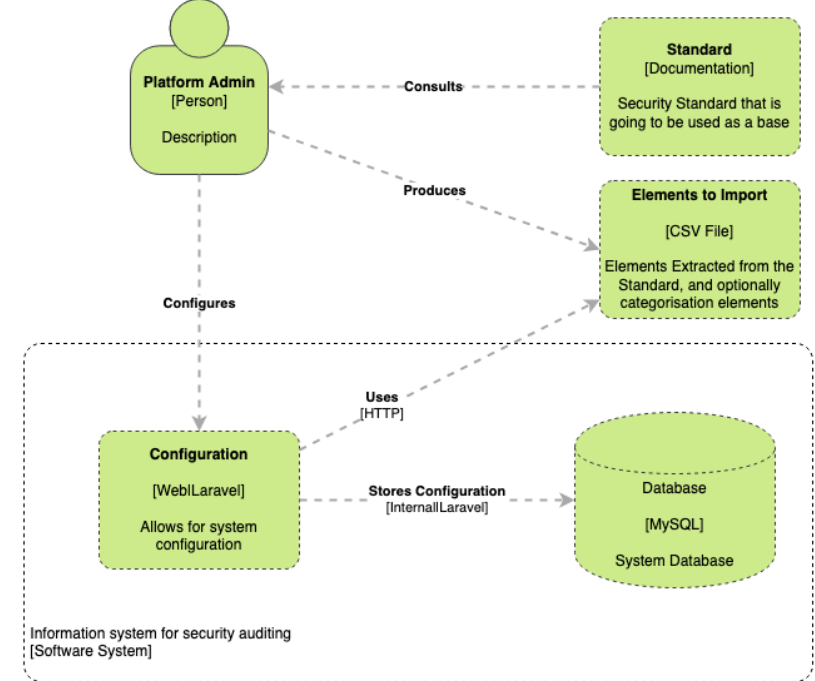
Figure 2. The C4 Level 2 diagram of the customization